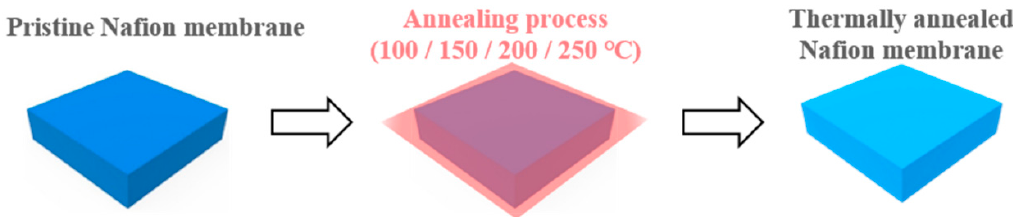
Figure 1. Schematic illustration of annealing treatment on pristine Nafion ® membrane at various temperatures, 100 °C (N211@100), 150 °C (N211@150), 200 °C (N211@200), 250 °C (N211@250), for 2 h.